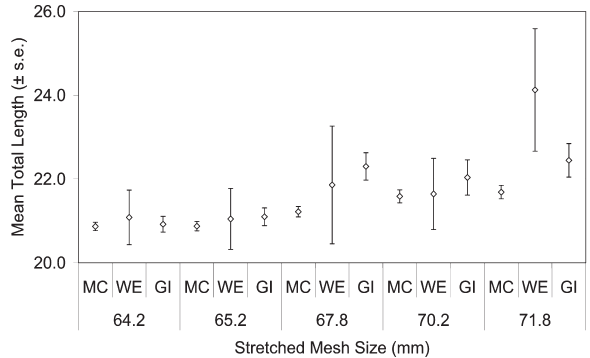
Fig. 5. – Mean Total Length of soles caught in gill nets with the three different methods of capture. MC = mouth clapped; WE = wedged; GI = gilled.